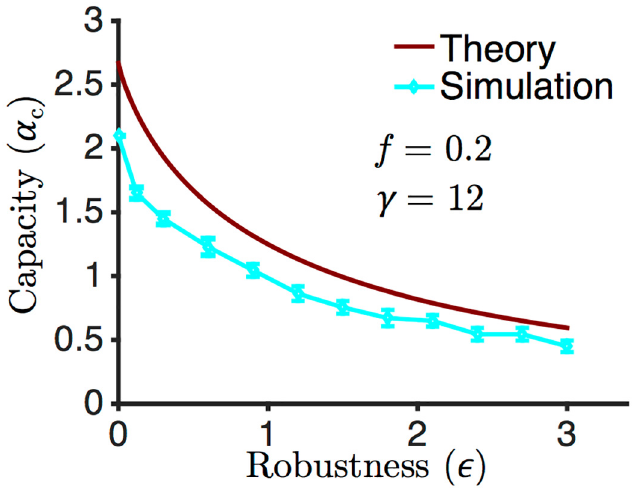
Fig 6. Capacity as a function of the robustness parameter (cid:2) at sparseness f = 0.2. The theoretical calculations is compared with the simulations for f = 0.2. Note that the capacity in the sparse regime is higher than in the dense